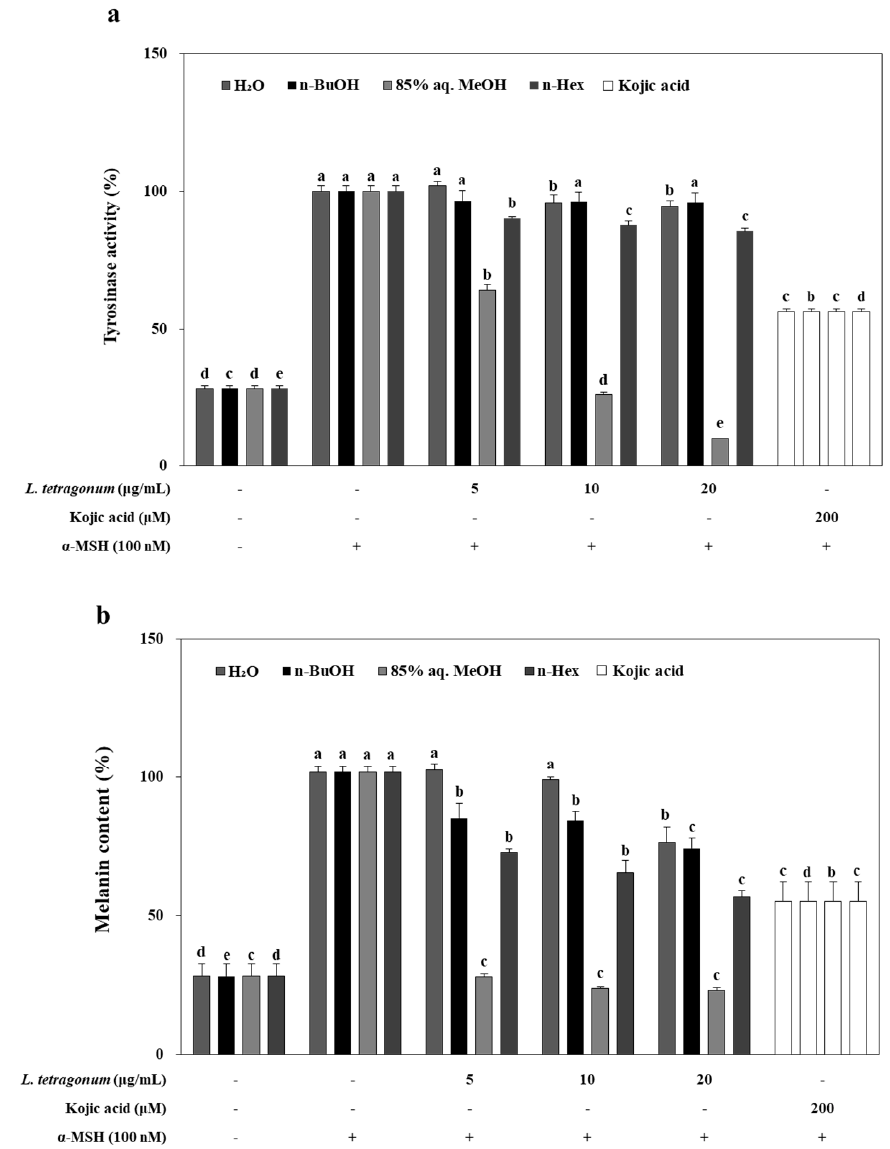
Figure 2. Inhibition of cellular tyrosinase activity ( a ) and reduction in melanin content ( b ) in B16-F10 cells by L. tetragonum solvent-partitioned fractions and kojic acid. a–e Means with the different letters are significantly different ( p < 0.05) by Duncan's multiple range test among same samples compared to control group.